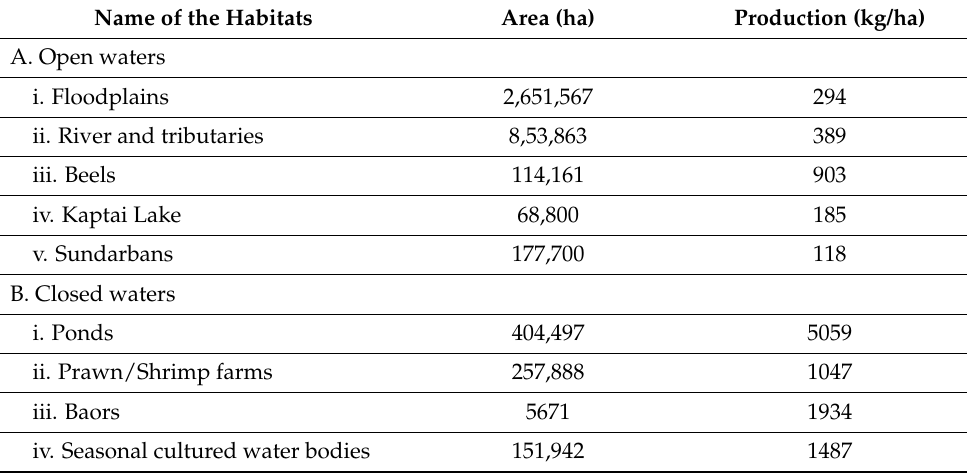
Table 3. The inland fish habitats of Bangladesh and production in 2019–2020. Name of the Habitats Area (ha) Production